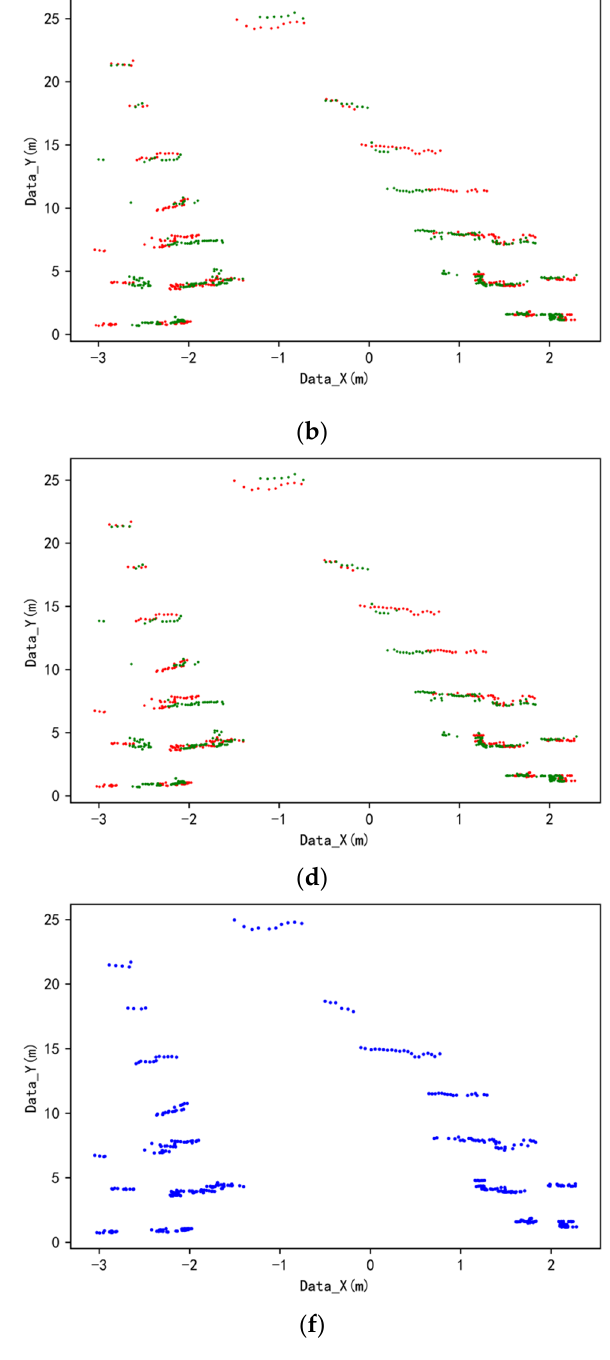
Figure 7. The 2D-ICP algorithm registration process. ( a ) First point cloud registration; ( b ) second point cloud registration; ( c ) third point cloud registration; ( d ) fourth point cloud registration; ( e ) last point cloud registration; ( f ) results after two-frame point cloud alignment.